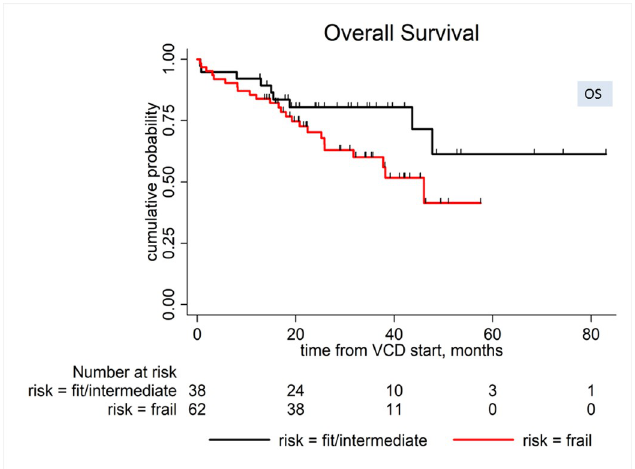
Fig 2. Overall survival (OS) by frailty (frail vs. intermediate or fit): (46 months vs. not reached, HR:1.94, 95% CI 0.89–4.2, p = 0.094).